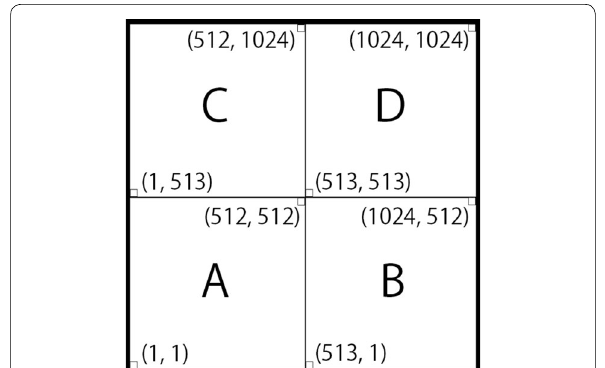
Table 2 Sagittarius stars for alignment check and radiometric calibration